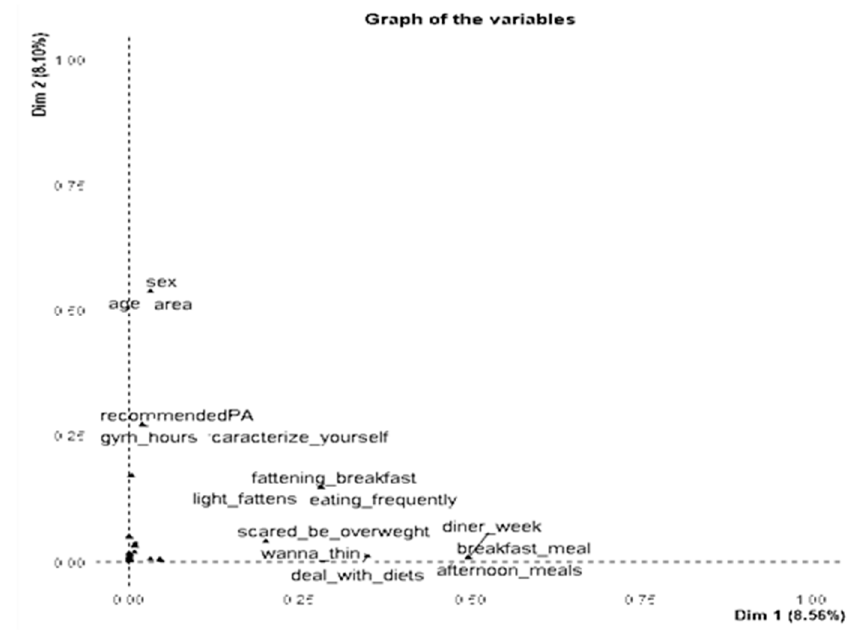
Figure A2. The first 15 well projected variables for the first two dimensions. Table A1. Regions and Prefectures included in the sample.